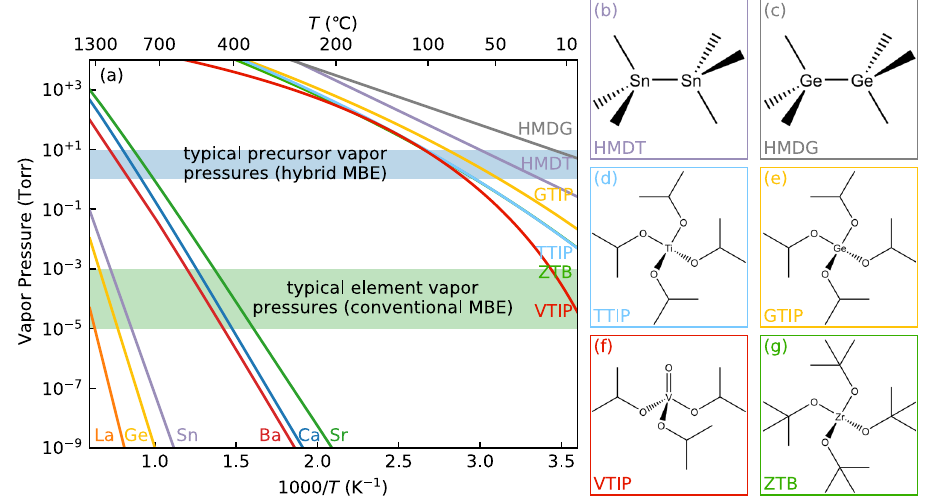
Fig. 2 Vapor pressures and structures of metal – organic precursors. a Vapor pressures of common elements in Ge-based oxides compared to precursors for hybrid MBE. b – g The chemical structures of the precursors including hexamethylditin (HMDT, b ) 16,38 , hexamethyldigermanium (HMDG, c ), titanium tetraisopropoxide (TTIP, d ) 39,40 , germanium tetraisopropoxide (GTIP, e ), vanadium oxytriisopropoxide (VTIP, f ) 41 , and zirconium tert -butoxide (ZTB, g ) 42,43 . All metal vapor pressures use the equations from Alcock and coworkers 44 . Ge uses a fi t to data from ref. 45. The vapor pressures for GTIP, TTIP, and VTIP use Antoine parameters from ref. 46 who themselves took this data from ref. 47 . HMDT data use the enthalpy of vaporization from ref. 48 and the standard entropy of vaporization fi t to boiling temperatures from chemical suppliers. HMDG data use Trouton ’ s rule along with a boiling temperature provided from